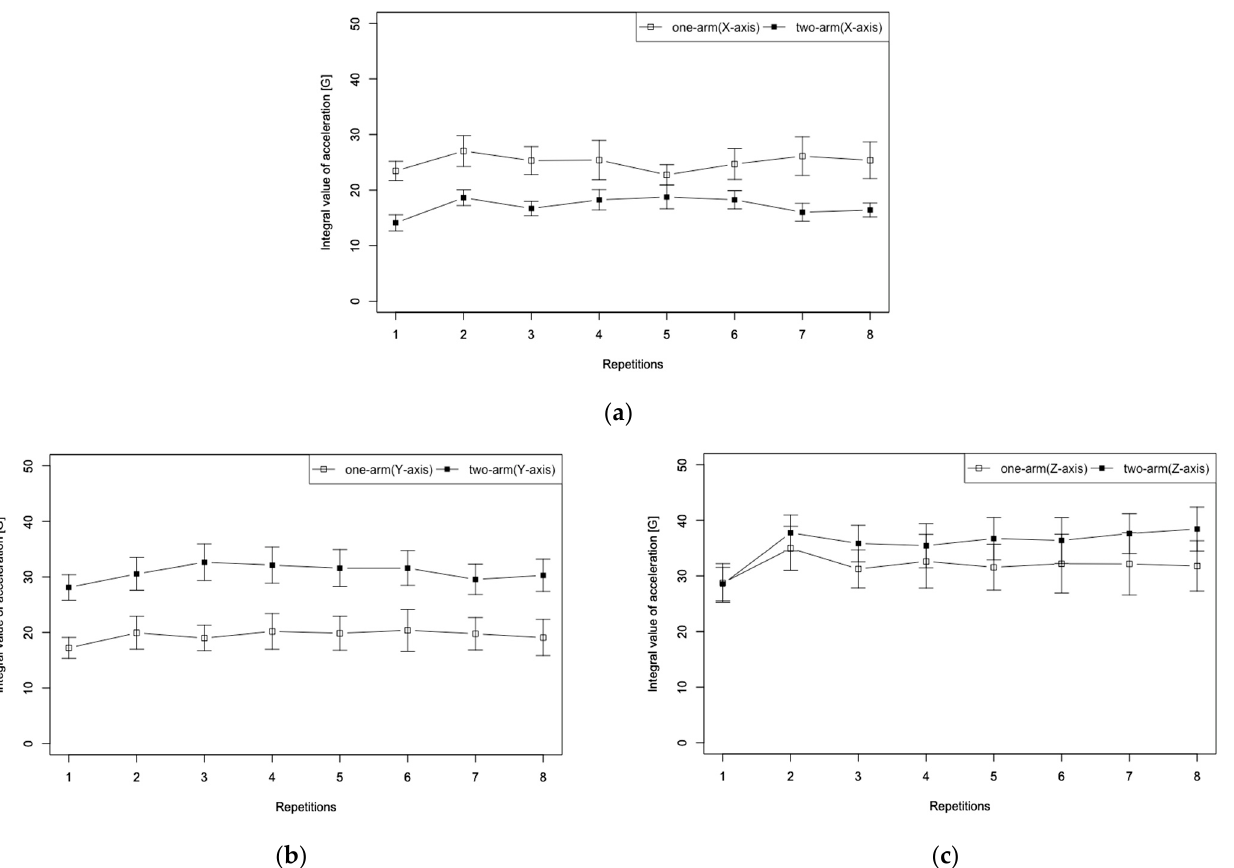
Figure 9. Body axis change results obtained for one-arm and two-arm driving for eight repetitions: ( a ) X-axis, ( b ) Y-axis, and ( c ) Z-axis.